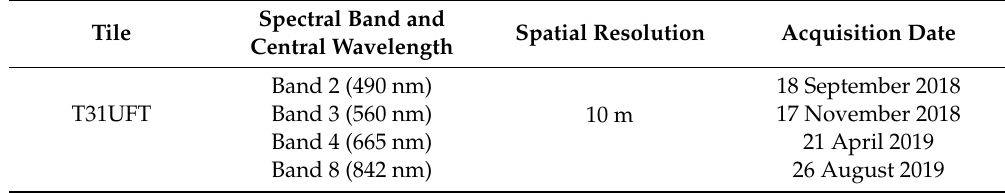
Table 2. Characteristics of Sentinel-2 satellite data used in this